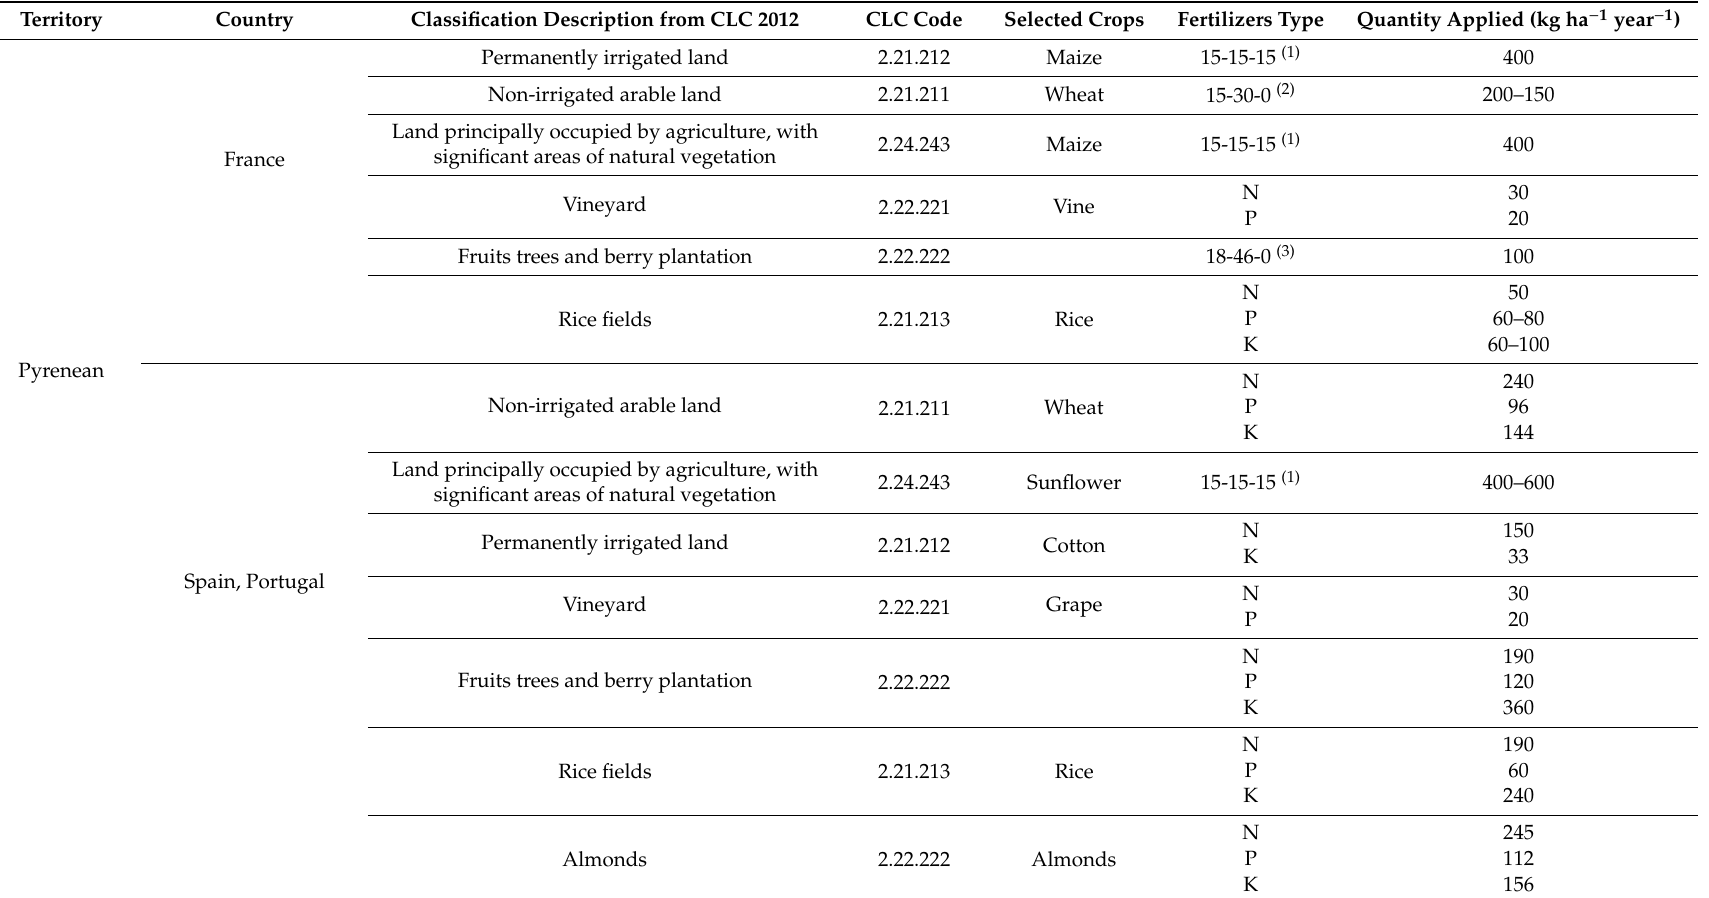
Table 2. Type of crops and technical management integrated into the model for CC and AC calibrations recommended by institutions. For AC, the amount of fertilizers was calibrated according to the crop yields outputs (Supplementary Materials Table